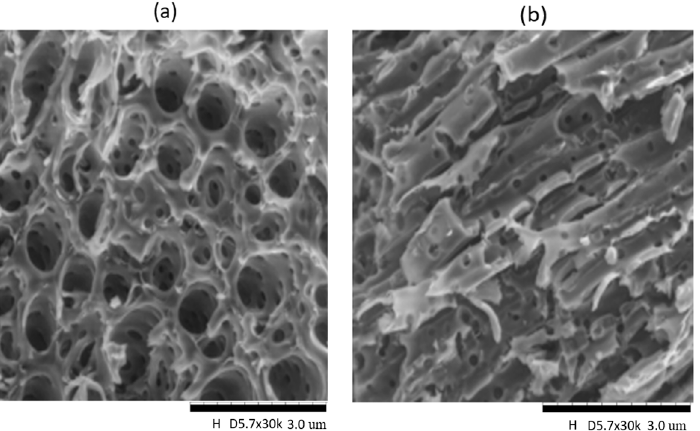
Figure 1. SEM image of ( a ) date pits cellulose (DPC) and ( b ) dried amine-functionalized lignin-free LCB (DPC-NH 2 ). LCB (DPC-NH 2